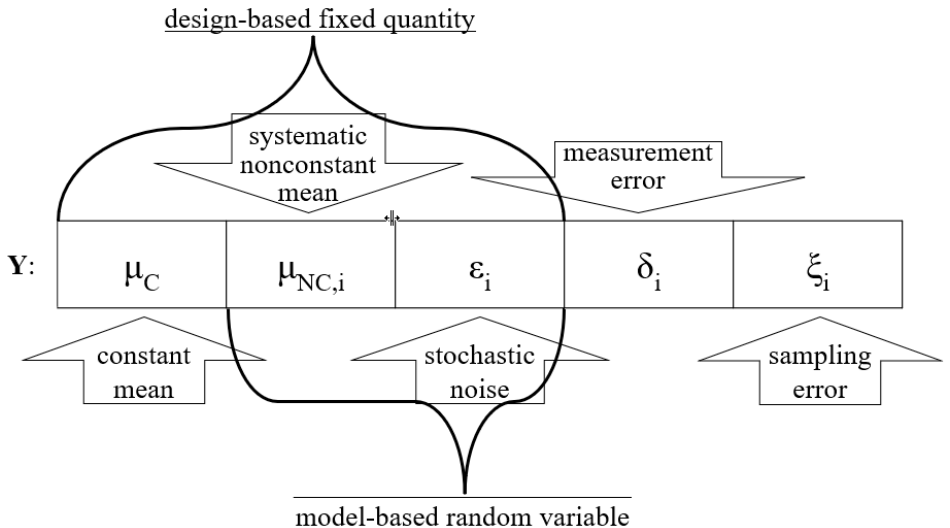
Figure A1. Decomposition of a single value of a (random) variable